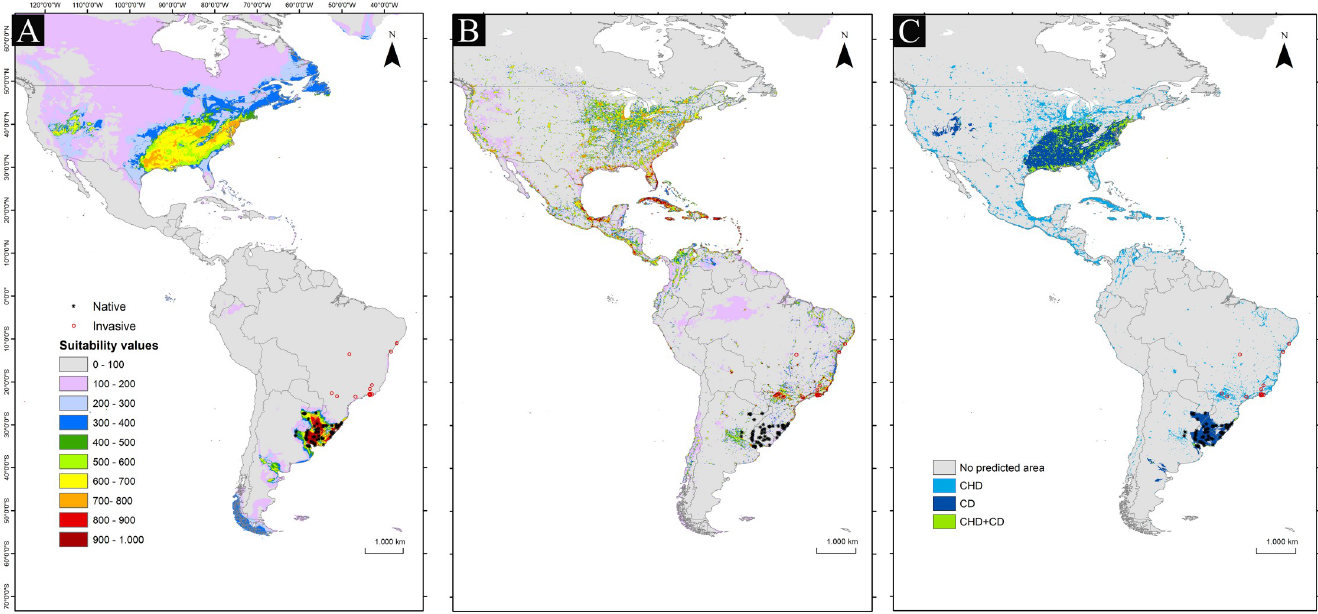
Fig 1. The resulting suitability areas for the successful establishment of T . dorbigni in the Americas. ( A ) climate-only model (CD); ( B ): climate + human activity model (CHD); ( C ) comparison of predicted distributions in the CD and CHD models; light blue areas show where the CHD model predicts species presence, while dark blue areas areas show where the CD model predicts species presence. Areas in green indicate coincidence in model predictions. Map images hosting provided by the Center for Spatial Sciences at the university of California,